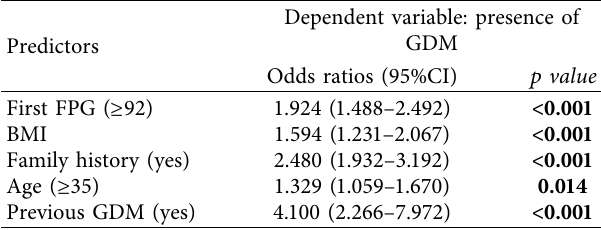
Table 2: Multivariate analysis to identify predictors in early pregnancy of subsequent GDM based on first fasting plasma glucose levels < 92mg/dl or ≥ 92mg/dl.